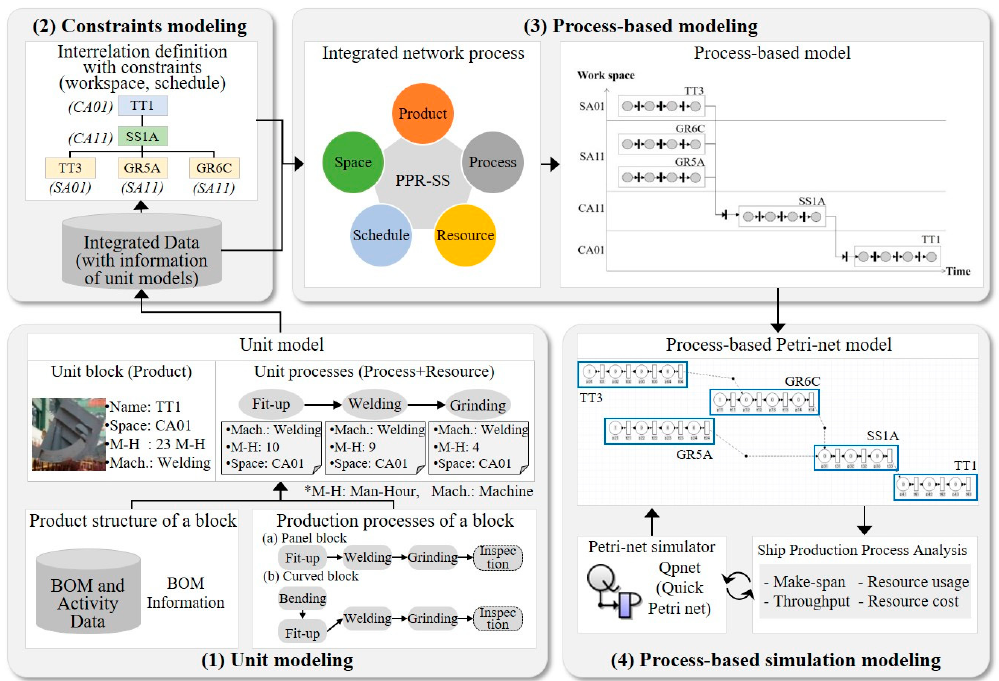
Figure 11. Illustration demonstrating a TT1 block’s production process through the process-based modeling (PBM)